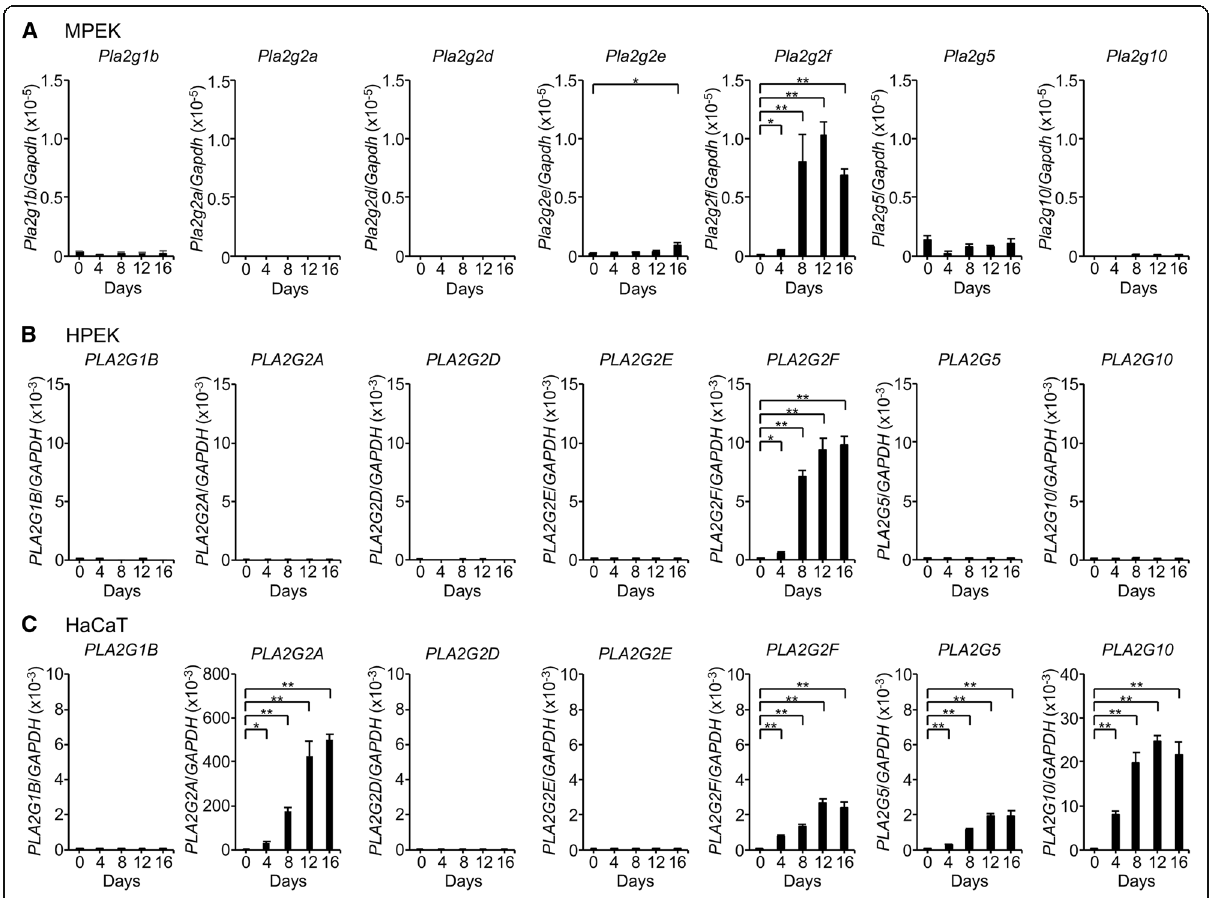
Fig. 3 Expression of sPLA 2 s in mouse and human keratinocytes. Quantitative RT-PCR of various sPLA 2 s in MPEKs ( a ), HPEKs ( b ), and HaCaT cells ( c ) that were cultured for the indicated periods with 1 mM Ca 2+ ( n = 4, mean ± SEM, * P < 0.05). PLA2G2F is the dominant sPLA 2 expressed in MPEKs and HPEKs, whereas PLA2G2A > PLA2G10 > PLA2G2F > PLA2G5 are expressed in HaCaT